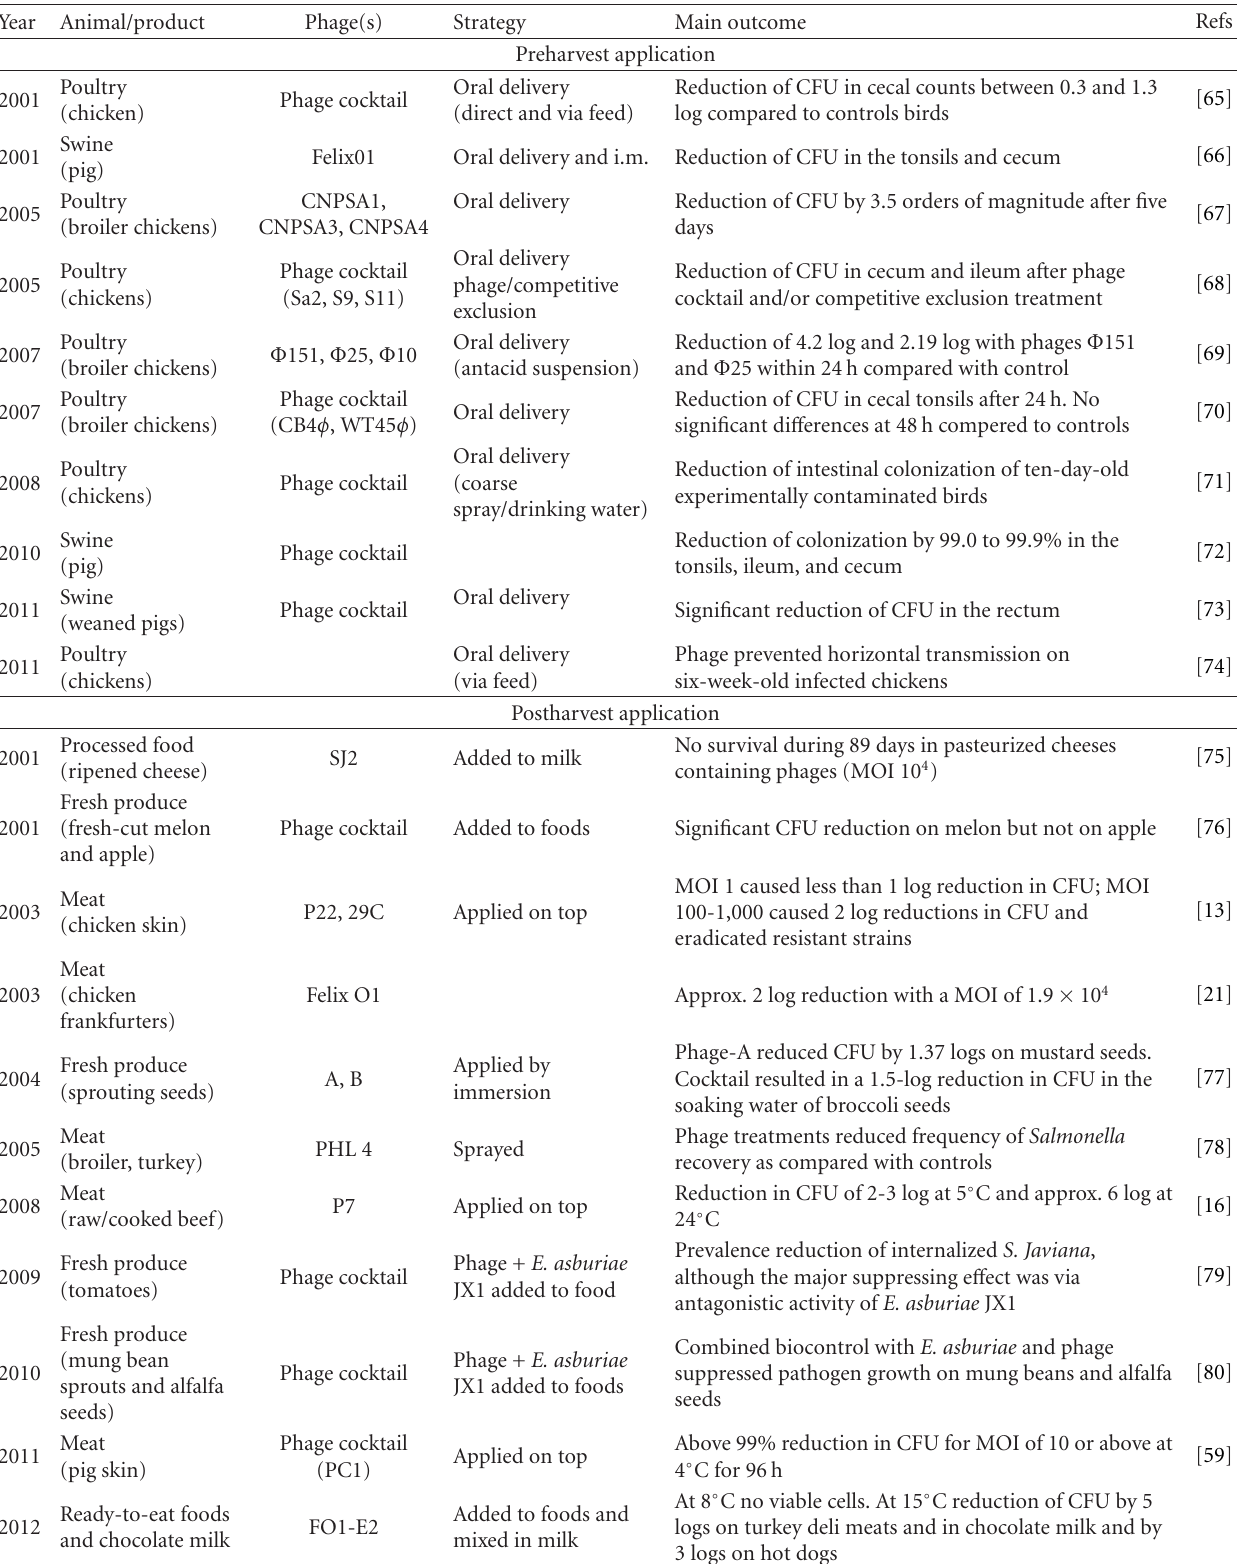
Table 3: Pre- and postharvest Salmonella phage